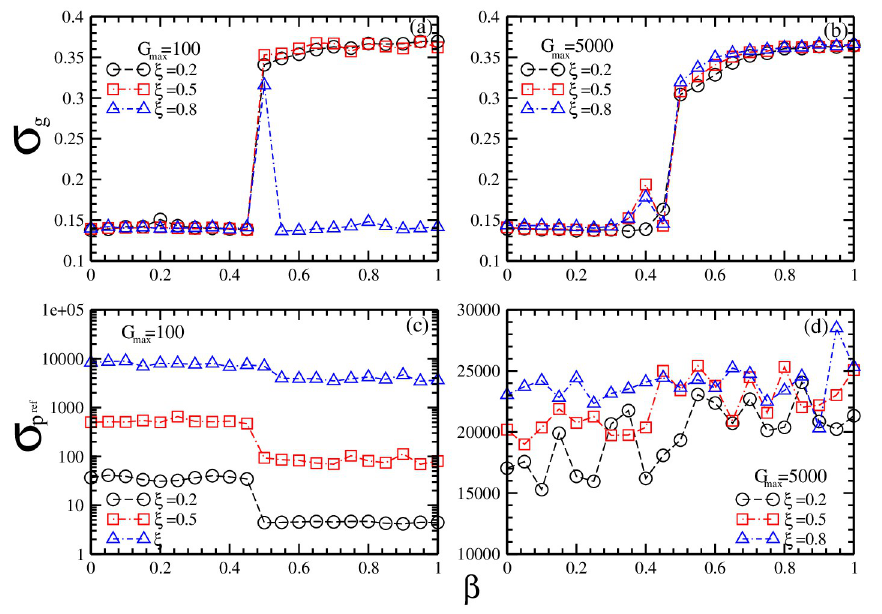
Fig 6. The standard deviation of investment strategies as a function of market impact β for different combinations of maximal risk tolerance G of reference point strategies and the ratio ξ of individuals with max reference point strategies. (a) σ g for G max = 100 and ξ = 0.2 (circles), 0.5 (squares), 0.8 (triangles); (b) σ g for G max = 5000 and ξ = 0.2 (circles), 0.5 (squares), 0.8 (triangles); (c) s for G = 100 and ξ = 0.2 (circles), 0.5 (squares), 0.8 max p ref (triangles); (d) s for G = 5000 and ξ = 0.2 (circles), 0.5 (squares), 0.8 (triangles). Other parameters are: the max p ref population size N = 5001, the memory size m = 3 and m 0 = 10, the updating threshold of history-dependent strategies , the constant a ¼ 10 , minimum S th = 0, the maximum drift of history-dependent strategies ε = 0.1, the liquidity l ¼ N 10 N and maximum shares holding k min = -1, k max = 1. The initial conditions are: an individual’s risk tolerance G i is uniformly distributed within the range of G i 2 [0, G max ], an individual’s initial reference point p ref is uniformly i 2 ½ � Pe (cid:0) a G i ; � Pe a G i � , initial history-dependent strategy g is distributed uniformly within distributed within the range of p ref i the range of g 2 [0, 1], starting price P ( t = 0) is randomly chosen within the range of P 2 [0, 20], each individual’s initial number of shares k = 0, each individual’s initial wealth W ( t = 0) = 0, each individual’s initial cash C ( t = 0) = i i